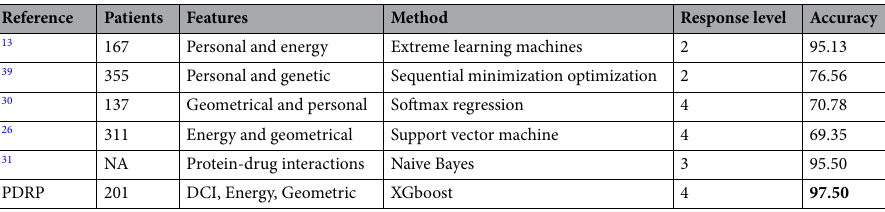
Table 2. Comparison of PDRP with other methods. The best accuracy is in bold. The 2-class response includes complete response and no-response, while 3-class response includes low, moderate, and full response. The 4-class response includes complete-response, partial-response, no-response, and progresive disease.